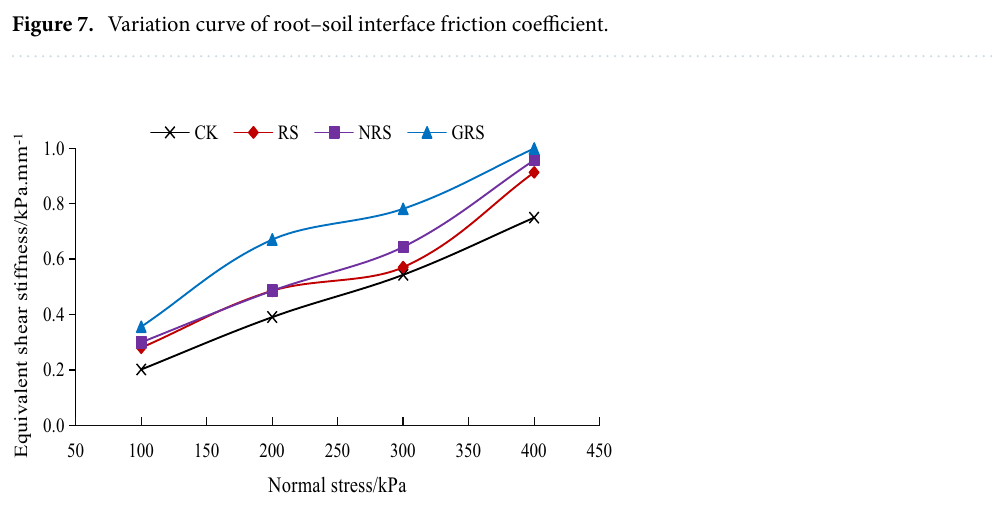
Figure 8. Variation curve of equivalent shear stiffness of root–soil